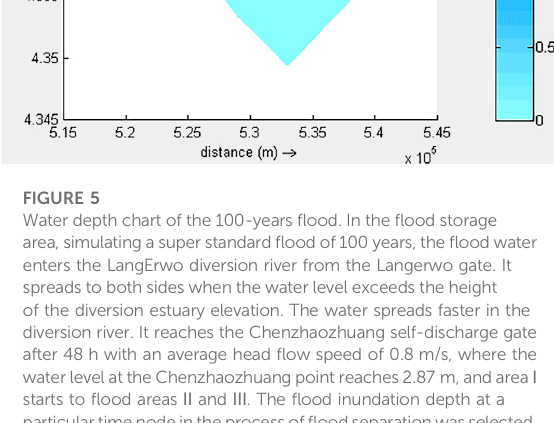
FIGURE 6 Flow process line of fl ood diversion gate. The hydraulic characteristics data of all the observation points under the two fl ood separation schemes of the Jinbao Highway can be obtained from the numerical model for the 100-years fl ood. The process line of fl ow at the fl oodgate under the two fl ood separation schemes is typical.